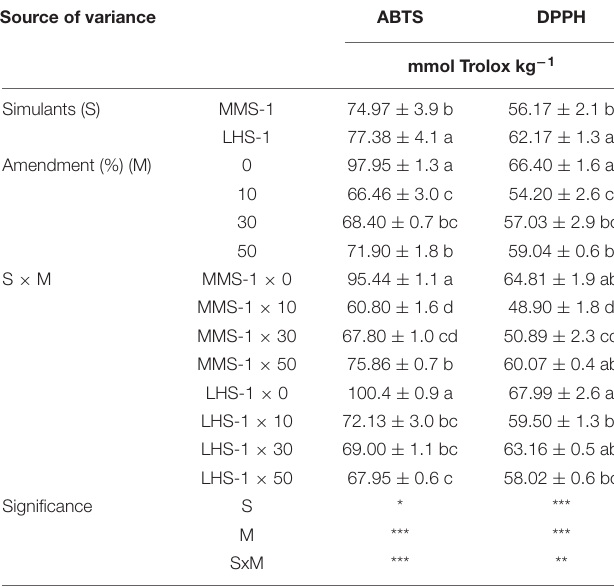
TABLE 2 | Antioxidant activity of lettuce grown in different mixtures of MMS-1 or LHS-1 simulants and manure (simulant/manure rates: 100:0, 90:10, 70:30, 50:50; w/w).